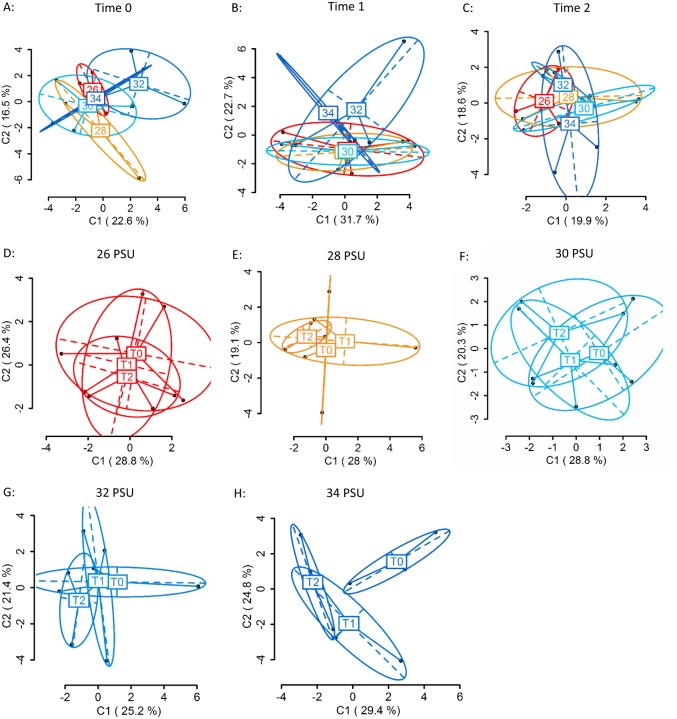
 Principal Coordinate Analysis (PCoA) of methylation (MSL) differences between colonies exposed to 34, 32, 30, 28 and 26 PSU.(A) between colonies at Time 0 (T0), prior to salinity treatment exposure (baseline methylation); (B) between colonies at Time 1 (T1) following a gradual salinity decrease of 1 PSU per day until all salinity treatments were reached: 34 PSU (control) (n = 3), 32 PSU (n = 3), 30 PSU (n = 3), 28 PSU (n = 3) and 26 PSU (n = 3); (C) at Time 2 (T2) after three days of decreased salinity exposure; (D) between sampling time points (T0, T1, T2) in colonies held at 26 PSU; (E) 28 PSU; (F) 30 PSU; (G) 32 PSU; (H) 34 PSU. The first two coordinates (C1 and C2) are shown with the percentage of variance explained by them. Points in each group cloud represent individuals from different groups. Labels show the centroid for the points cloud in each group. Ellipses represent average dispersion of those points around their centre (Pérez-Figueroa, 2013). AMOVA tests for significant differences in methylation (MSL) are shown in Tables S6 and S7. No significant differences between groups were found.